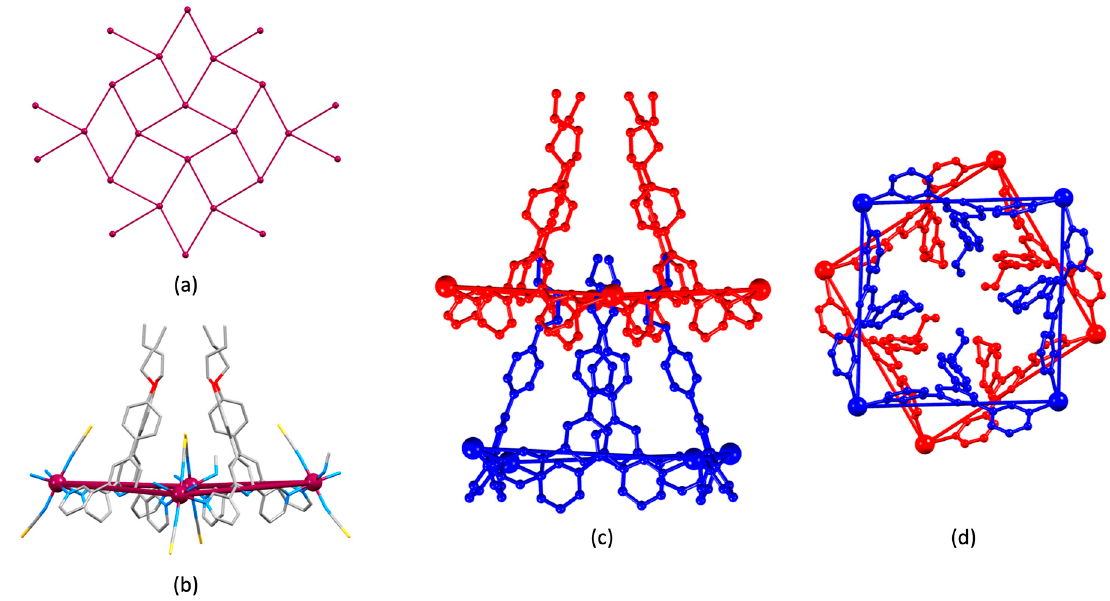
Figure 1. ( a ) Part of one (4,4) net in [{Co( 1 ) 2 (NCS) 2 } · 4CHCl 3 ] n ; ( b ) the cone-like arrangement of four ligands 1 around the edges of one of two geometrically different rhombuses; ( c ) and ( d ) the relationship between the rhombuses shown in diagram ( b ) in adjacent sheets [6].